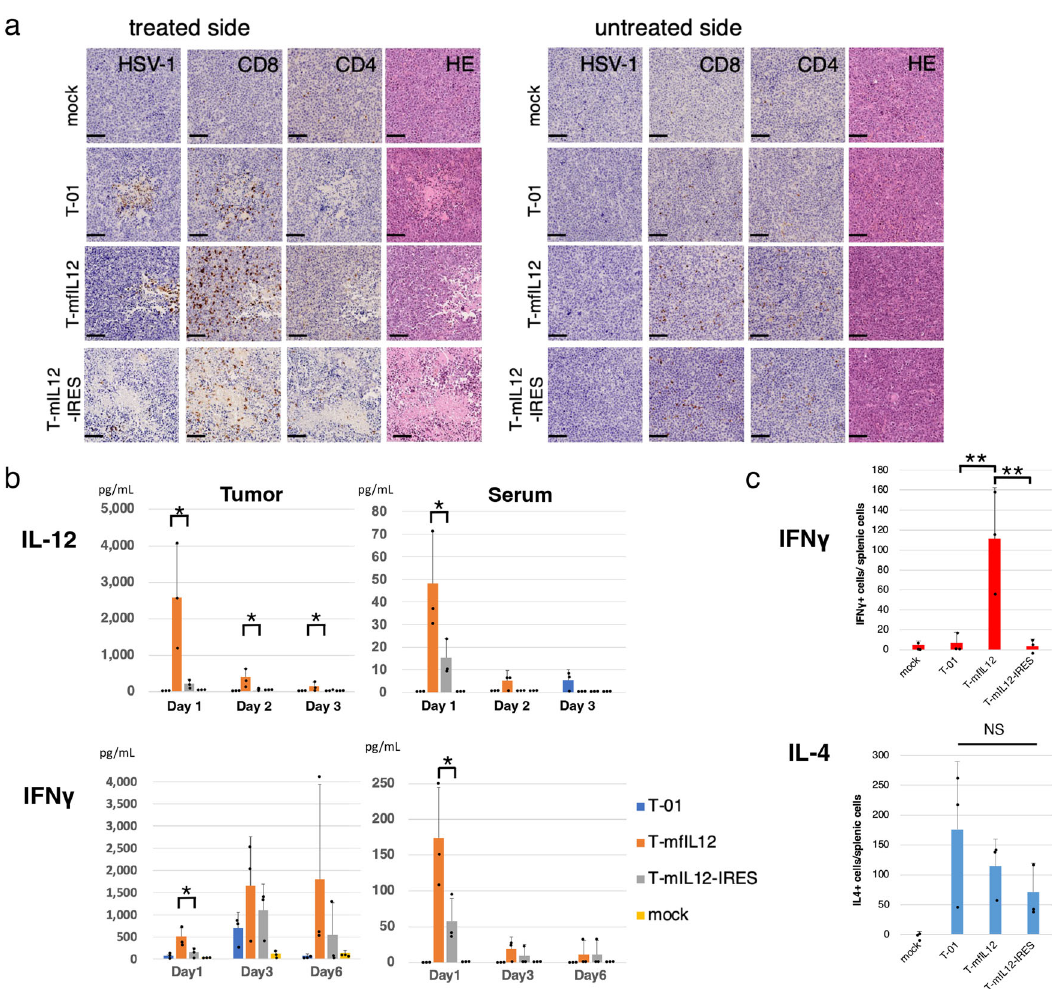
Fig. 5 Immune responses by T-mfIL12 and T-mIL12-IRES. a Immunohistochemistry. Bilateral subcutaneous Neuro2a tumors were generated in A/J mice, left tumors only were inoculated with T-mfIL12, T-mIL12-IRES, T-01 (2 × 10 5 pfu) or mock on days 0 and 3, and the tumors were harvested on day 6 (n = 3 per group). An increased in fi ltration of CD4 + and CD8 + lymphocytes were observed in the tumor for all three viruses, both in the treated and the untreated side, most prominently with T-mfIL12 (Fig. 5a). HSV-1 positive cells were observed in the tumor with all viruses in the treated side, but not in the untreated side. HE, hematoxylin and eosin. Scale bars, 100 μ m. b In vivo levels of interleukin-12 (IL-12) and Interferon γ (IFN γ ). In the unilateral subcutaneous Neuro2a model, established tumors were inoculated with T-01, T-mfIL12, T-mIL12-IRES (2 × 10 6 pfu) or mock, sera and tumor samples were collected on days 1, 3 and 6 (n = 3 per group), and the levels of mouse IL-12 and IFN γ were measured by ELISA. The intratumoral IL-12 levels for T-mfIL12 were signi fi cantly higher than those for T-mIL12-IRES at all time points ( p = 0.018, p = 0.016 and p = 0.046 for days 1, 3 and 6, respectively). The levels of IL-12 detected from the serum were remarkably lower than those in the tumor. Correlating with the intratumoral IL-12, the serum IL-12 level for T-mfIL12 was higher than that for T-mIL12-IRES on day 1 ( p = 0.047). The IFN γ levels of T-mfIL12 were signi fi cantly higher than those of T-mIL12-IRES both in the tumor and serum on day 1 ( p = 0.014 and p = 0.027, tumor and serum, respectively). c Immune responses speci fi c to Neuro2a cells. In the unilateral subcutaneous Neuro2a model, established tumors were inoculated with T-01, T-mfIL12, T-mIL12-IRES (5 × 10 4 pfu) or mock on days 0 and 3, and the spleen was harvested on day 6. By ELISpot assay, splenocytes from T-mfIL12-treated mice showed a signi fi cantly higher number of IFN γ release stimulated by Neuro2a cells than those from T-01- and T-mIL12-IRES- treated ones ( p = 0.005 and p = 0.004 vs T-01 and T-mIL12-IRES, respectively). No signi fi cant difference in number of IL-4 releasing splenocytes was observed among the three virus-treated groups. The IFN γ or IL-4 releases speci fi c to Neuro2a cells were calculated by subtracting the numbers of SaI/N responding spots from those of Neuro2a responding spots. For b and c , Graphs show the means. Dots represent individual data. Bars, SD. *, p < 0.05; **, p < 0.01; NS, not signi fi cant; one-way ANOVA with Tukey ’ s multiple